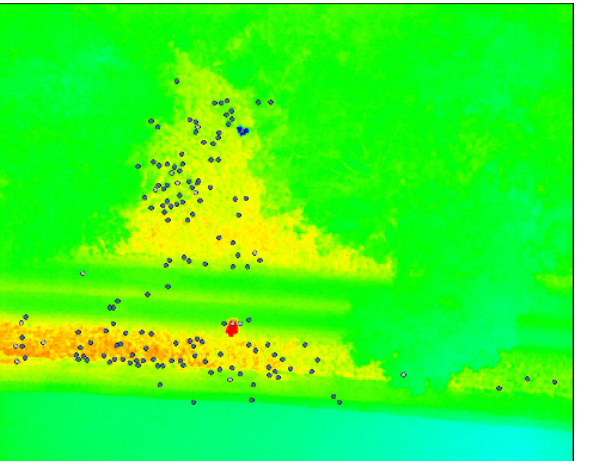
Figure 10: Thermal image at test site "Rietholzbach" with tie points (dots), temperature range: (15-33 °C), blue,green: forest, red: drouthy grassland.